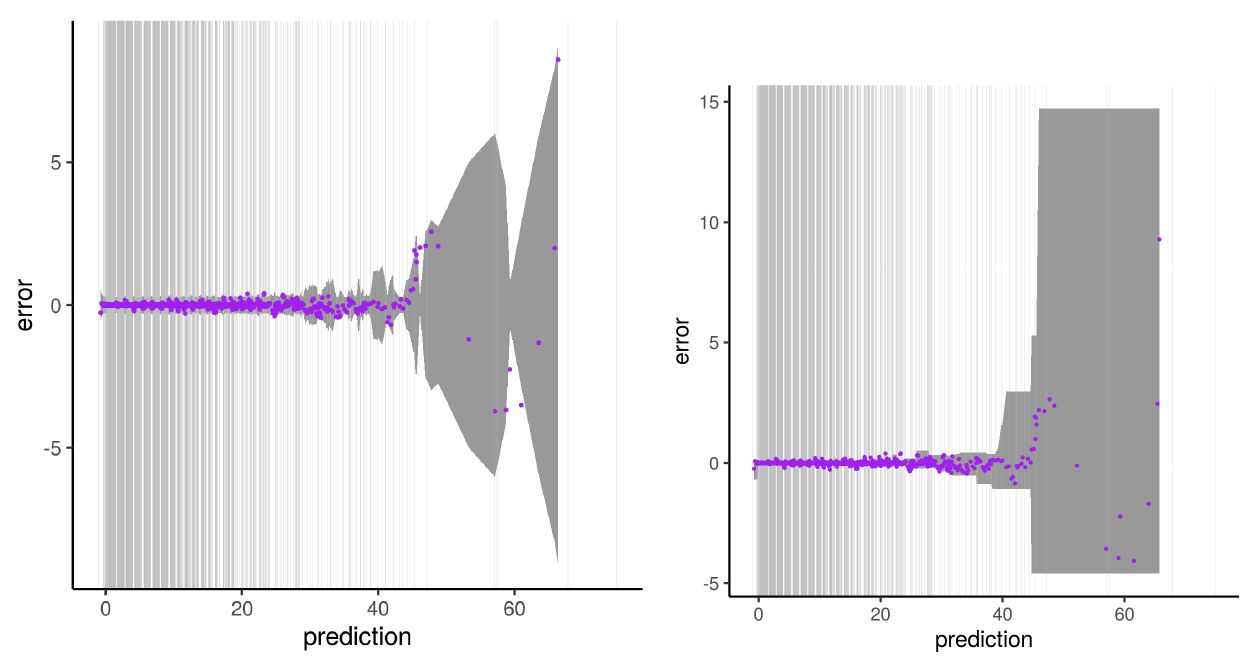
Figure 14. Same as Figure 12 for the third run of the experiment.